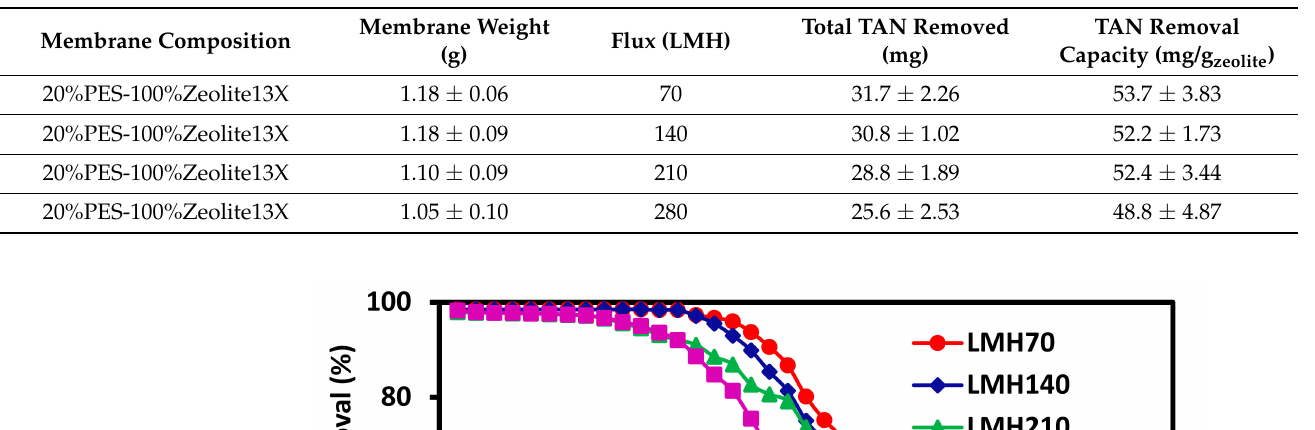
Table 1. The TAN removal capacity as a function of filtration flux.